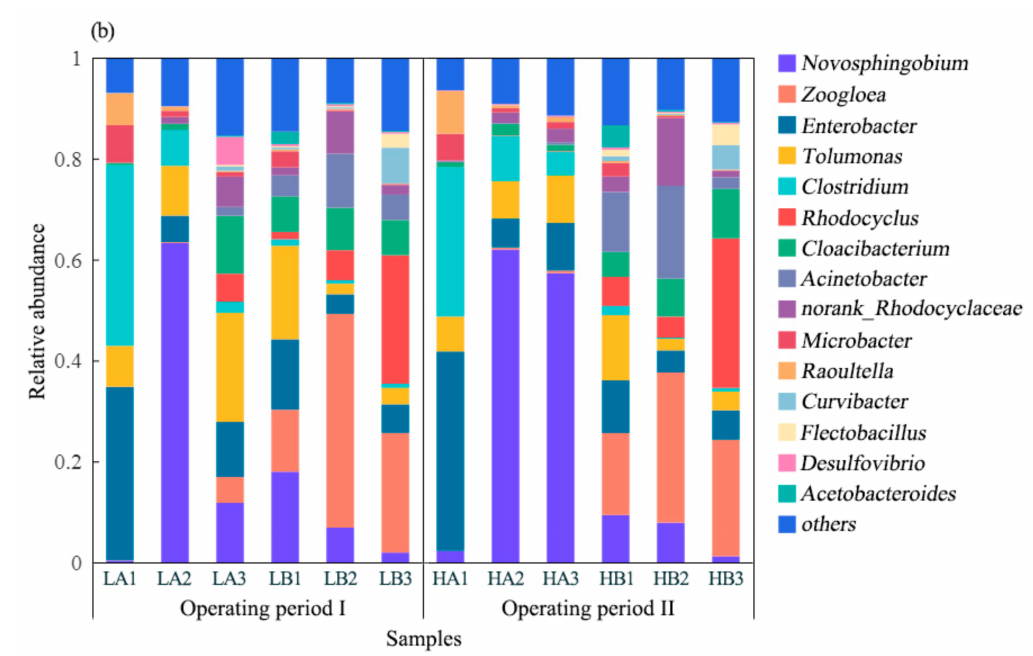
Figure 3. The relative abundance of bacteria along the filter under two organic loads. ( a ) At phylum level; ( b ) At genus